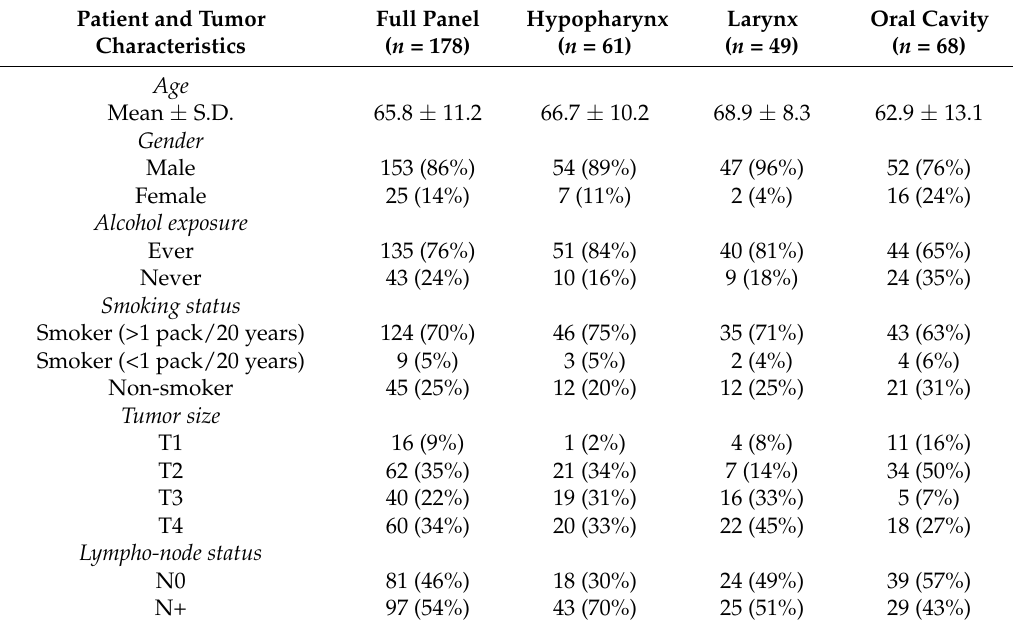
Table 1. Clinicopathological data of head and neck squamous cell carcinoma (HNSCC) patients under